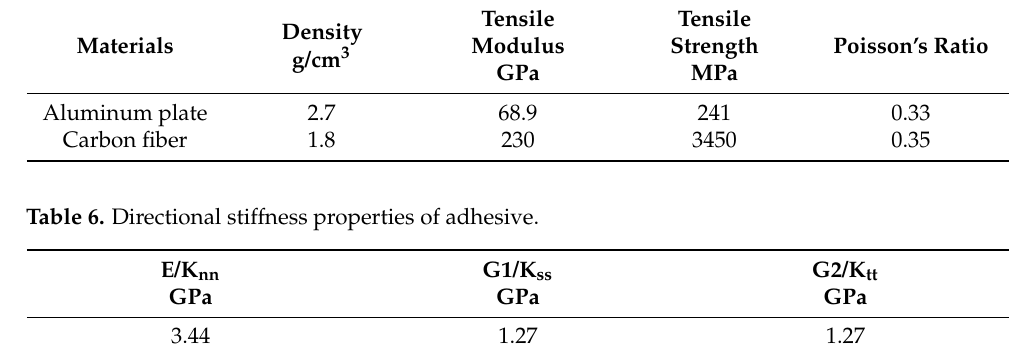
Figure 14. Final shape of the model after loading. Computational analysis was carried out on the double strap lap joints and is pre- sented in Table 7. The response of the match and mismatch joints under tensile loading depends on fracture energy, the value of which is almost the same for both configurations; therefore, given results are compared with the match joint only. However, a comparison with the mismatch joint is also presented in Figure 15. The failure load and fracture energy in simulation and experimentation are almost equal with only 0.5% and 0.58% relative error, respectively. Table 7. Simulation result of tensile test. Simulation Result